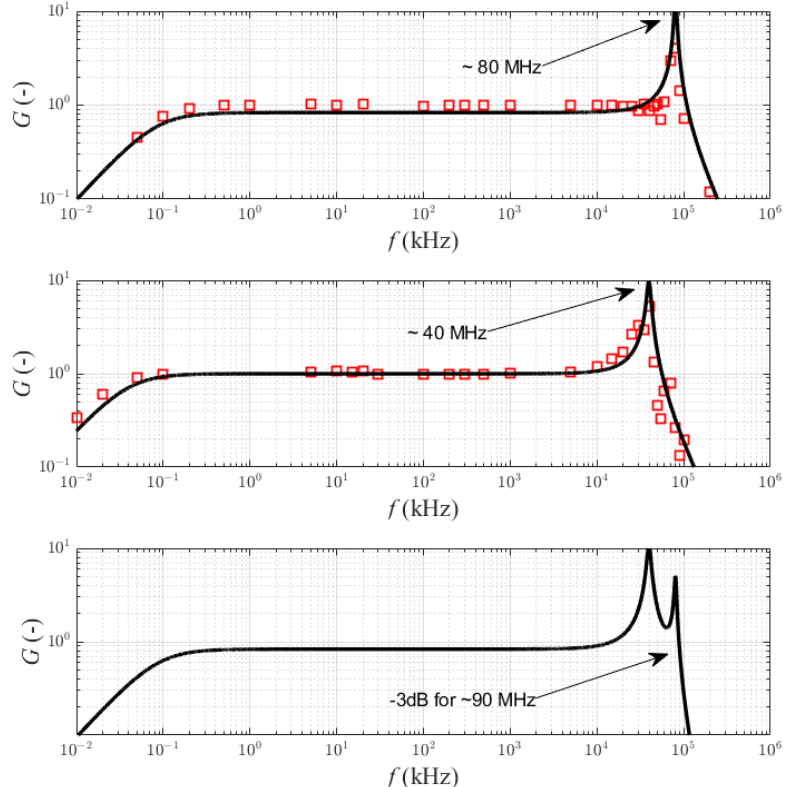
Figure 8. The Bode plots ( G —gain vs. frequency) of the proposed current sensors with dual connec- tion of two HFCTs, and the theoretical summaries of the frequency response for dual HFCT. The continuous line marks the analytical characteristics of the proposed sensor ob- tained based on the relationships (4) and (8). No measuring points were defined for the cascade connection of the sensors, which was caused by the low value of the generator excitation signal. The characteristics for the transmittances (13) and (15) were plotted, and the values of the lower and upper frequencies were determined from the dependence: